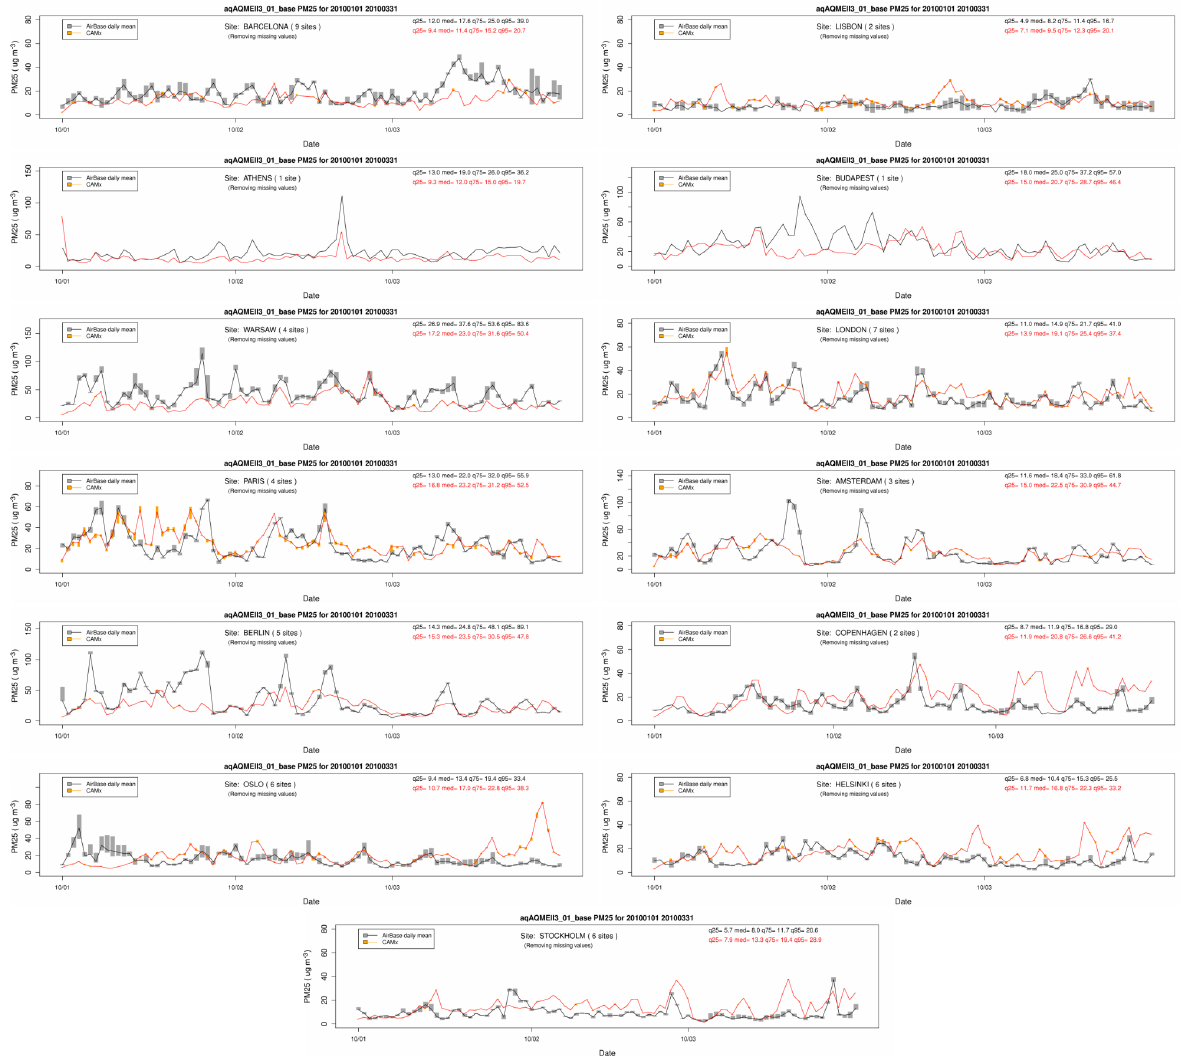
Figure 7. Time series of the box and whisker plots for the distribution of the observed (black and grey) and computed (red and orange) daily concentrations of PM 2 . 5 at background AirBase sites in the selected cities for 1 January–31 March 2010. Bars show the interquartile range and lines show the median values. Values for the 25th, 50th, 75th, and 95th quantiles are also reported for each